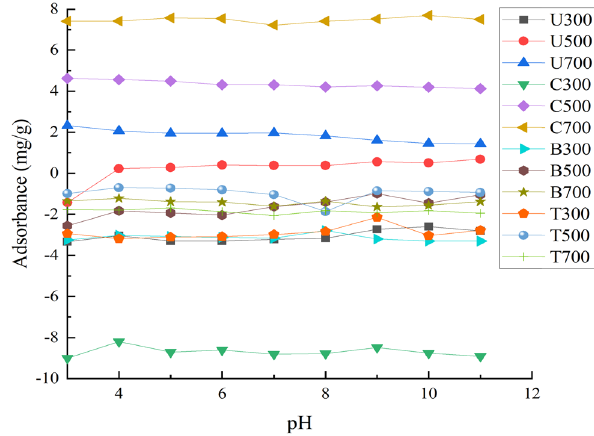
Figure 3: E ff ect of pH on adsorption capacity of 12 kinds of biochar.